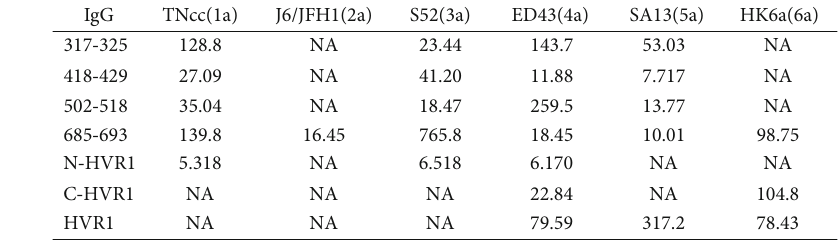
) and calculated using a “ variable slope ” 50